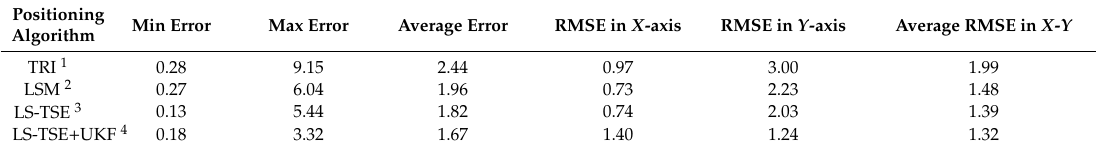
Table 3. The errors between each point and the fitting point after the second fitting in meter.